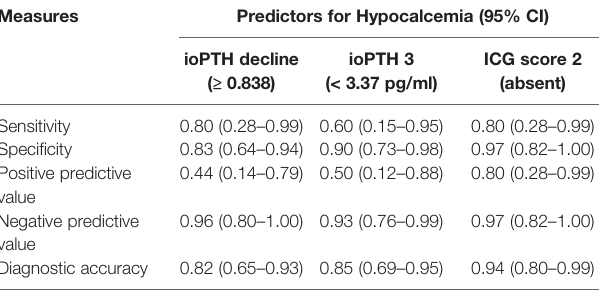
TABLE 5 | Diagnostic characteristics of different predictors for